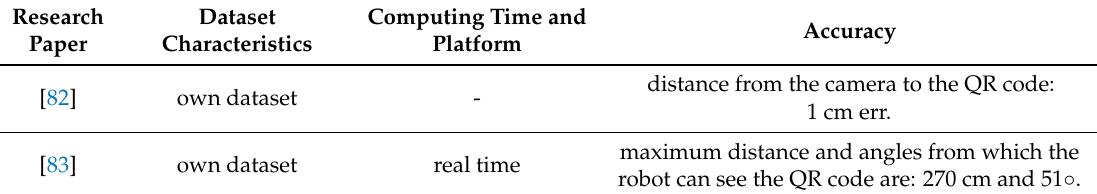
Table 6. Characteristics of indoor localization solutions with 3D mobile cameras, markers with known positions, and traditional image